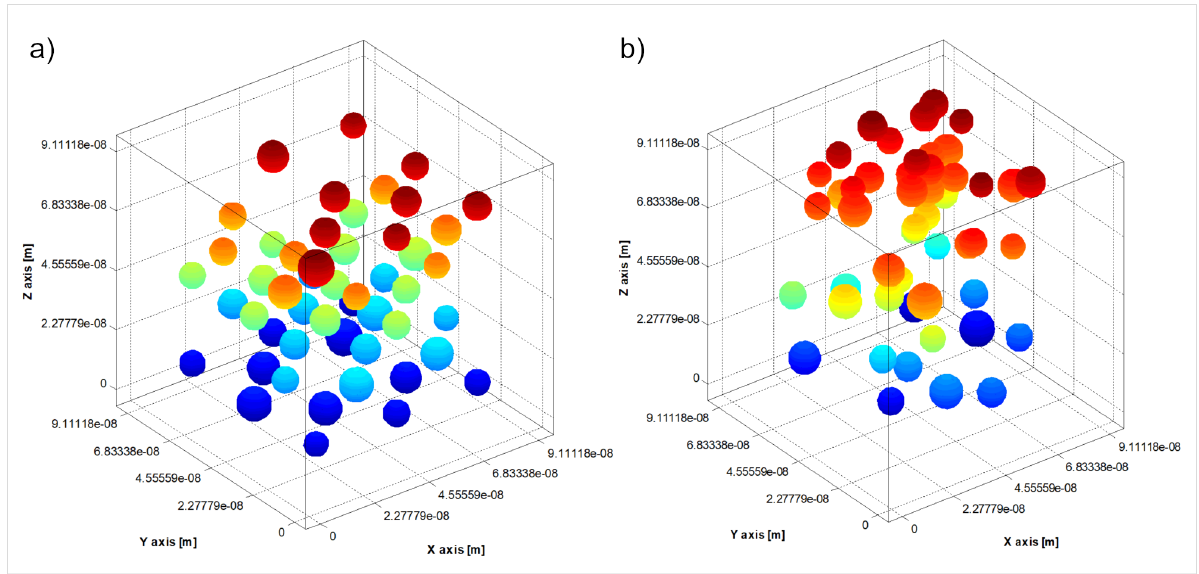
Figure 1: Positions of nanoparticles inside the test cube: a) initial moment; b) after 0.1 ms (thickness of the coating layer = 1 nm, polymer surface density ξ = 10 16 m − 2 ).